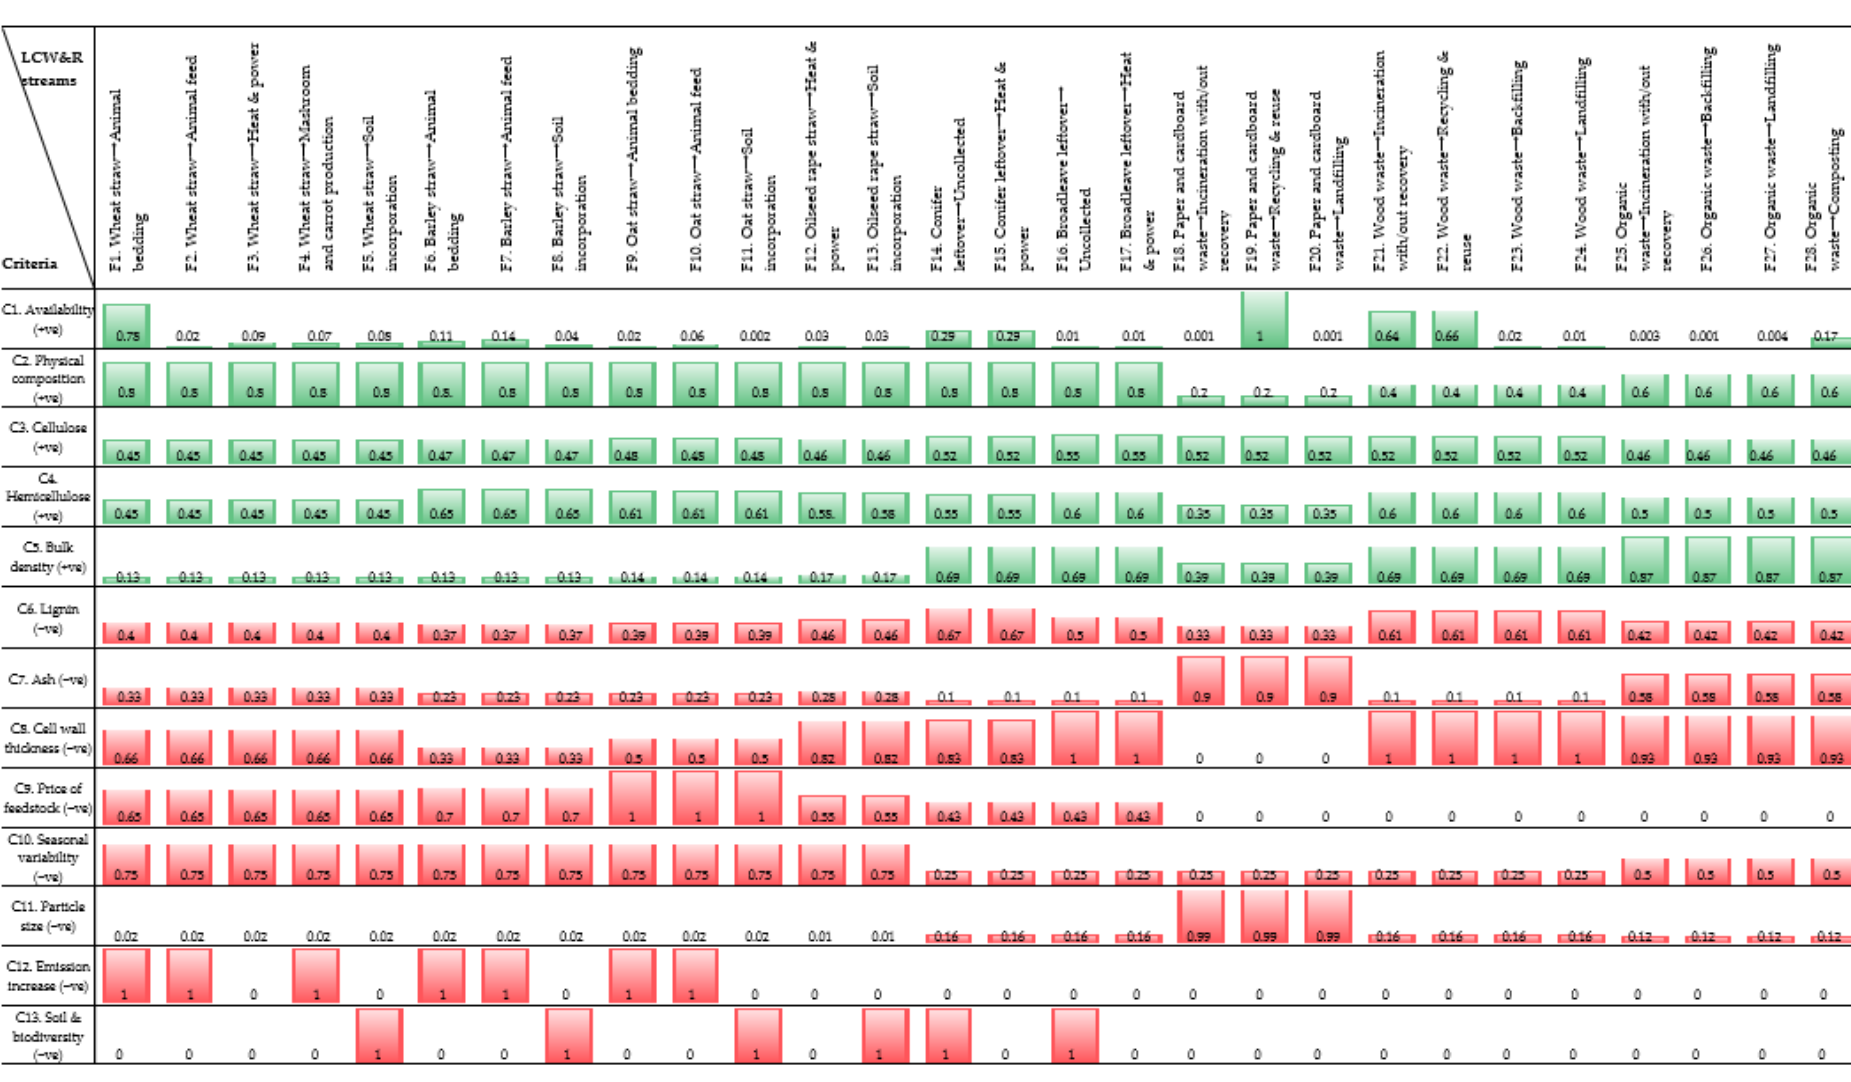
Figure 4. Performance matrix for the UK LCW&R streams. (+ve) and ( − ve) are used to indicate positive and negative criteria, respectively.